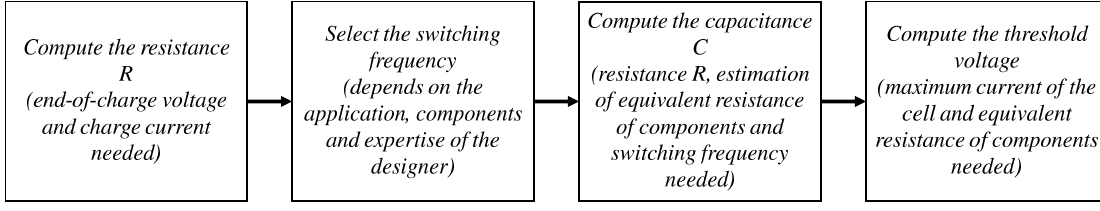
Figure 10. Flowchart of the design process.